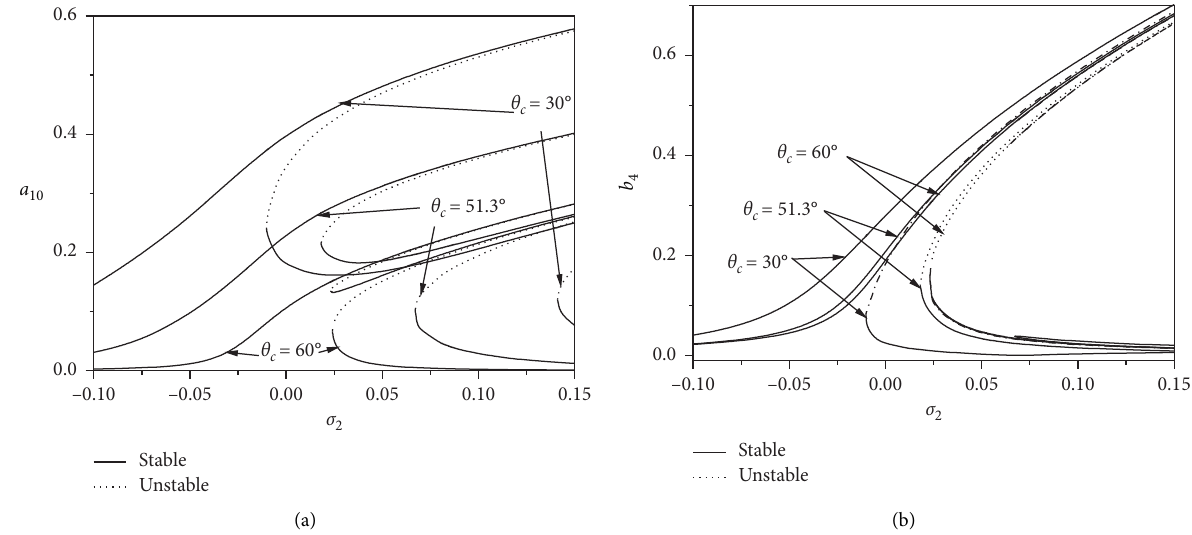
Figure 14: Effect of inclined angle θ c on the frequency-response curves of the (a) cable and (b) shallow arch with Ω 4 ≈ ω 2 , 4 and ω 1 , 10 ≈ ω 2 , 4